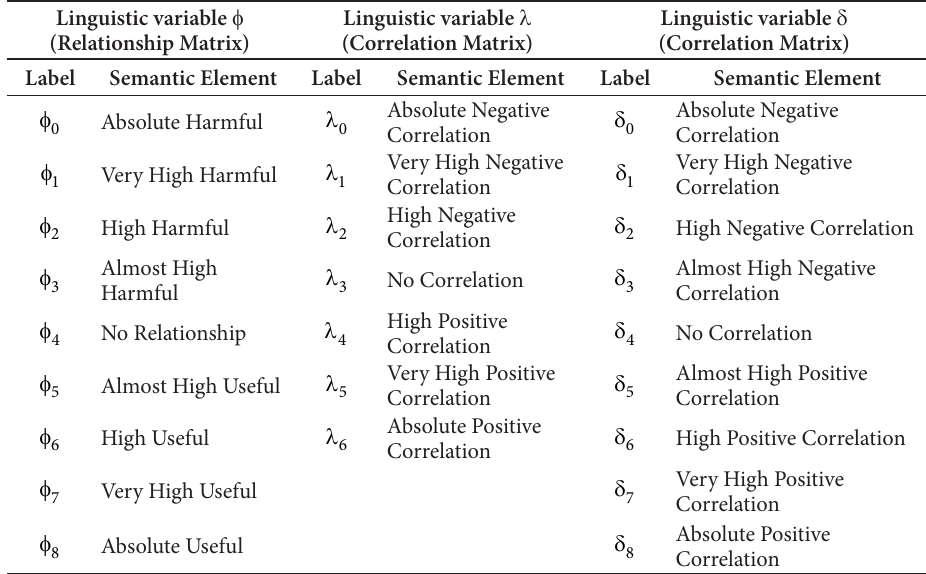
Table 3. Linguistic variables f , l , and d Linguistic variable f (Relationship